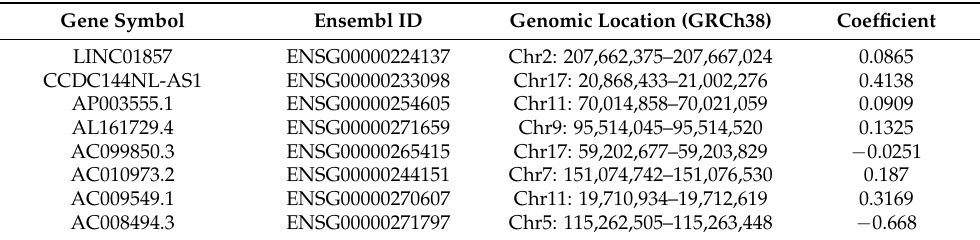
Table 1. The coefficients of eight ferroptosis-related lncRNAs of the multivariable Cox regression analysis in the training